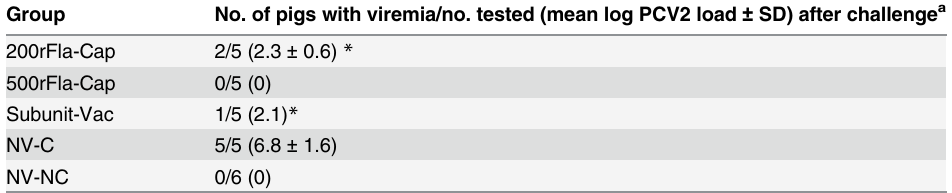
Table 3. Viral DNA load in the serum samples of rFla-Cap vaccinated pigs following PCV2 challenge.